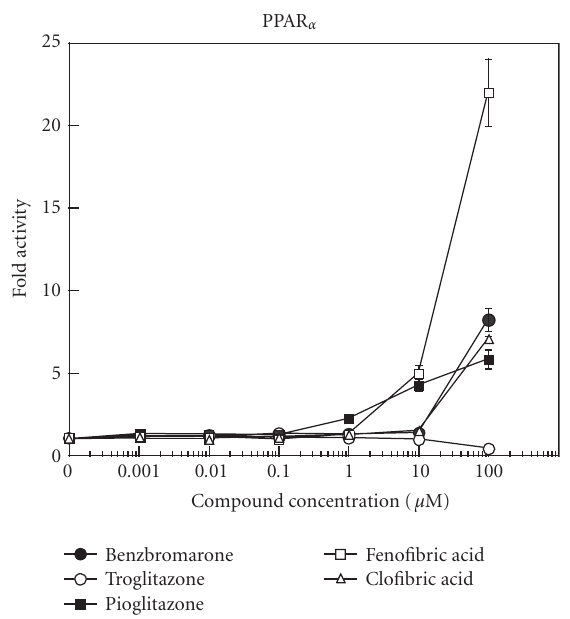
Figure 2: E ff ects of benzbromarone ( • ), troglitazone ( ◦ ), piogli- tazone ( (cid:2) ), fenofibric acid ( (cid:3) ), and clofibric acid ( Δ ) on PPAR γ activation. Cells were transfected using the receptor plasmid for the chimera of the PPAR γ ligand-binding domain and GAL4 DNA- binding domain, together with a reporter plasmid containing a GAL4-responsive promoter driving the expression of luciferase. Each point represents mean ± SD.